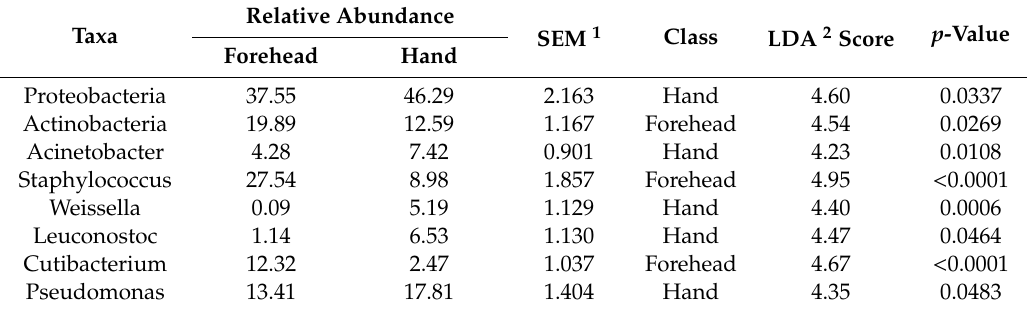
Table 3. Di ff erentially abundant taxa in di ff erent skin locations.